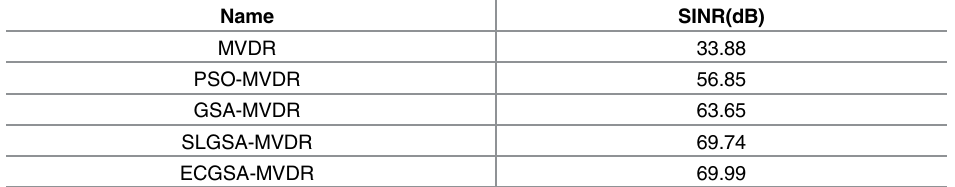
Table 11. Comparison of SINR calculation for conventional MVDR, PSO-MVDR, GSA-MVDR, SLGSA-MVDR [28] and ECGSA-MVDR for user at 0° and interference at 30°and